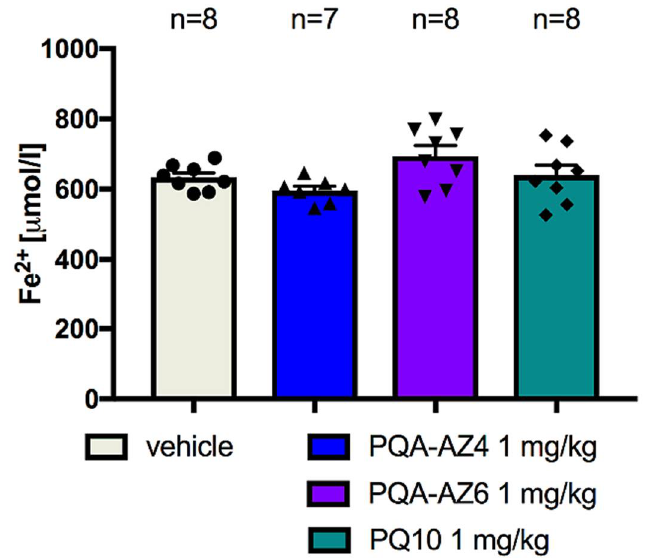
Figure 8. Ferric-reducing antioxidant power in serum after repeated administration of PQA-AZ4, PQA-AZ6, or PQ-10; PQA-AZ4, PQA-AZ6, and PQ-10 were administered i.p. once daily for 21 consecutive days. Data represent the mean ± SEM, n = 7–8 rats per group; statistical analysis was performed using the Student’s t -test.